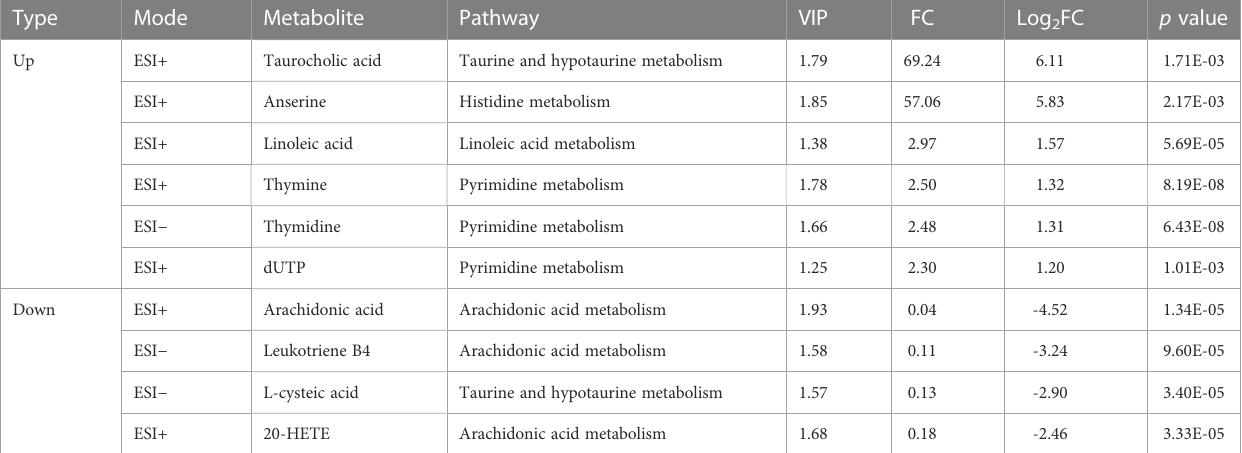
TABLE 2 Identi fi ed perturbed metabolites correlated to the signi fi cantly dysregulated metabolic pathways.